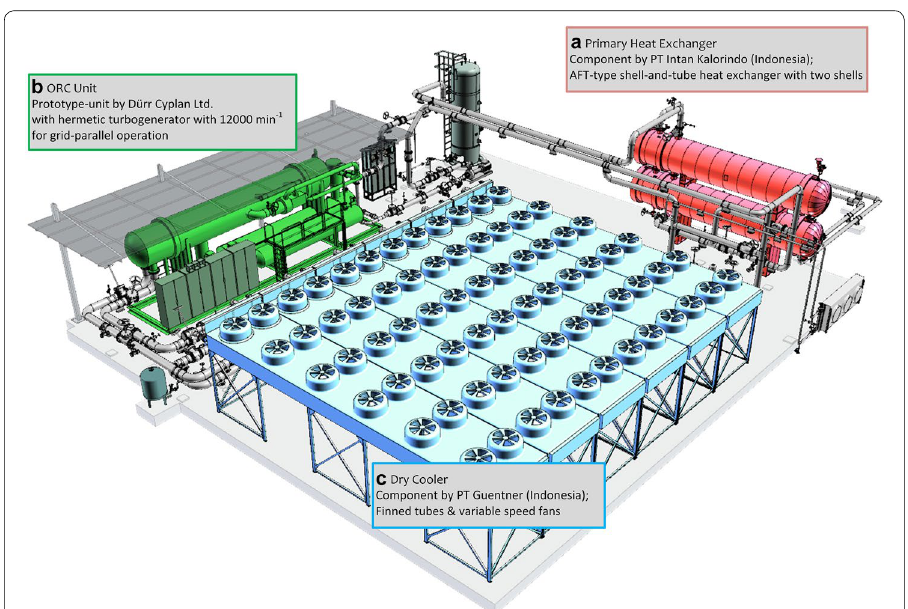
Fig. 2 3D-Plant layout showing primary heat exchanger ( a ), ORC-unit ( b ) and dry cooler ( c